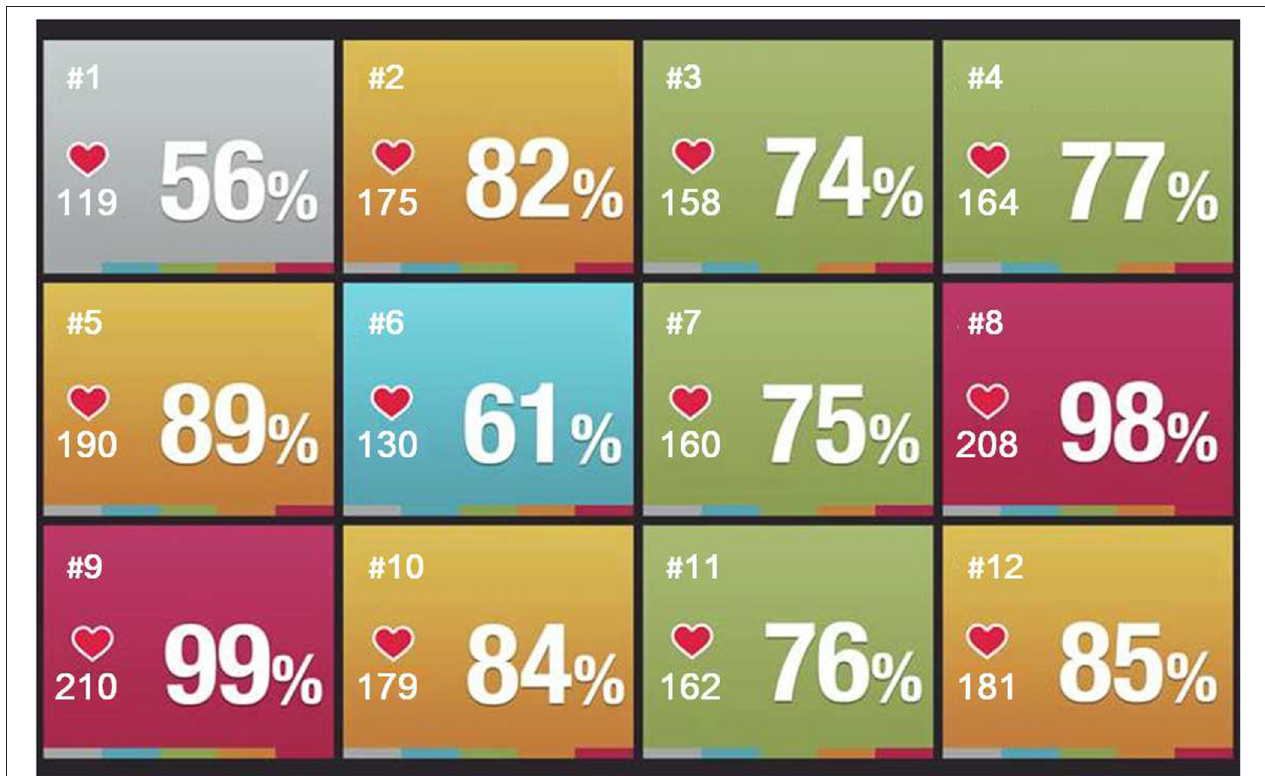
FIGURE 1 | Heart-rate feedback as provided on the projector screen during running. Displayed are the number of the participant in the upper left corner, the real-time heart-rate in beats per minute in the lower left corner under a heart symbol, the respective percentage of their maximum heart-rate emphasized on the right side and the respective heart rate zone indicated by the background color. In the present example all information were provided for 12 participants at a time with participants being identified by their participant number.